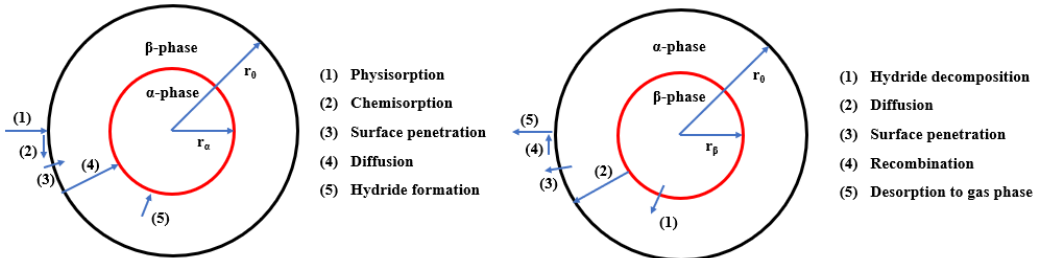
Figure 11. Reaction partial steps for the absorption ( left ) and desorption ( right ) of hydrogen by a spherical metal/hydride powder particle. (Reproduced with permission from ref. [140]. Copyright 1996 Elsevier).